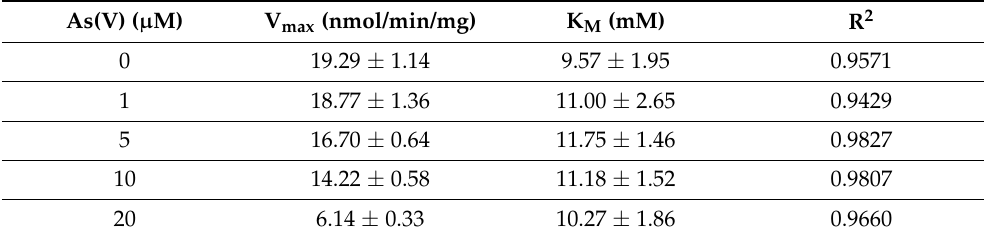
Figure 1. Graphical representation of Michaelis–Menten kinetics at different concentrations of ( a ) As(V) and ( c ) A(III) and their relatives Lineweaver–Burk double reciprocal plots in presence of ( b ) As(V) and ( d ) As(III). Table 1. Kinetics parameters, V max and K M , of the Tt ArsC phosphatase activity and respective R 2 values for nonlinear regression fitting at different As(V) concentrations.